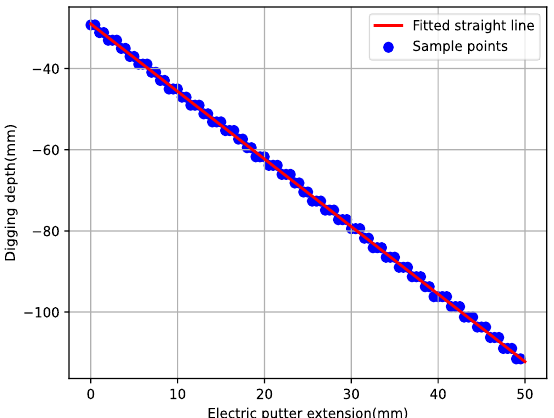
Figure 12. Electric putter extension and digging depth fitted straight line.